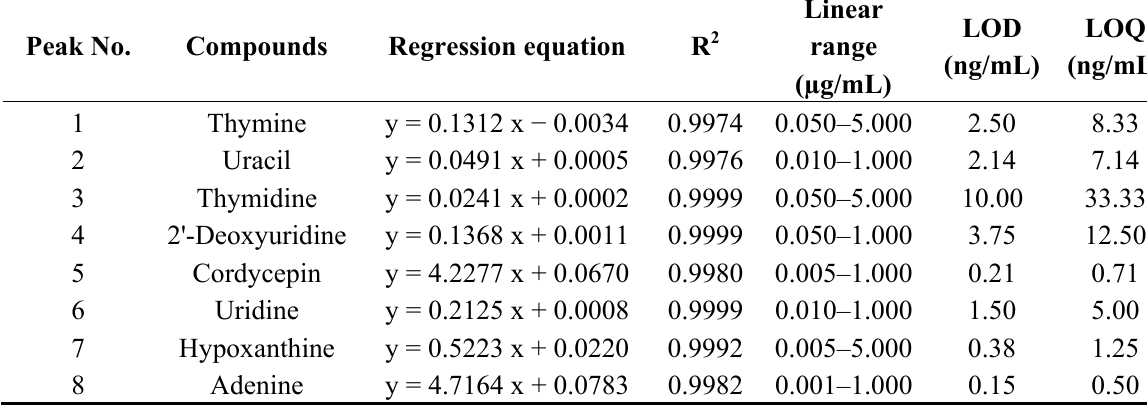
Table 3. Determination coefficients of 15 nucleosides and nucleobases determined by HILIC-ESI-MS/MS